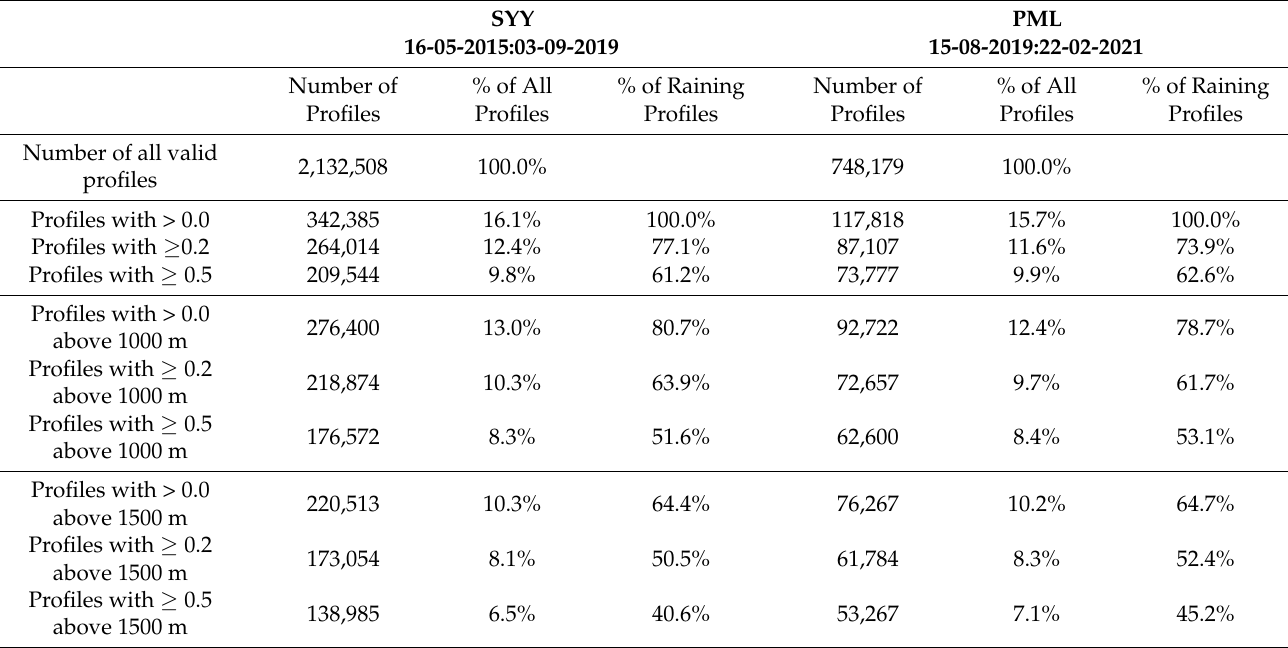
Table 2. Occurrence of precipitation by profile for SYY and PML. (Note the ‘at-surface’ precipitation is deemed to be precipitation in range bin 2 covering the 100–200-m